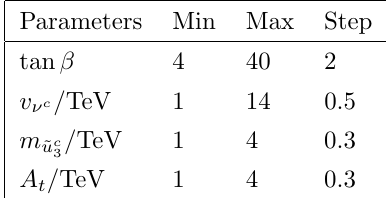
Table 1 . Scanning parameters for the muon MDM with M 2 = (cid:22)